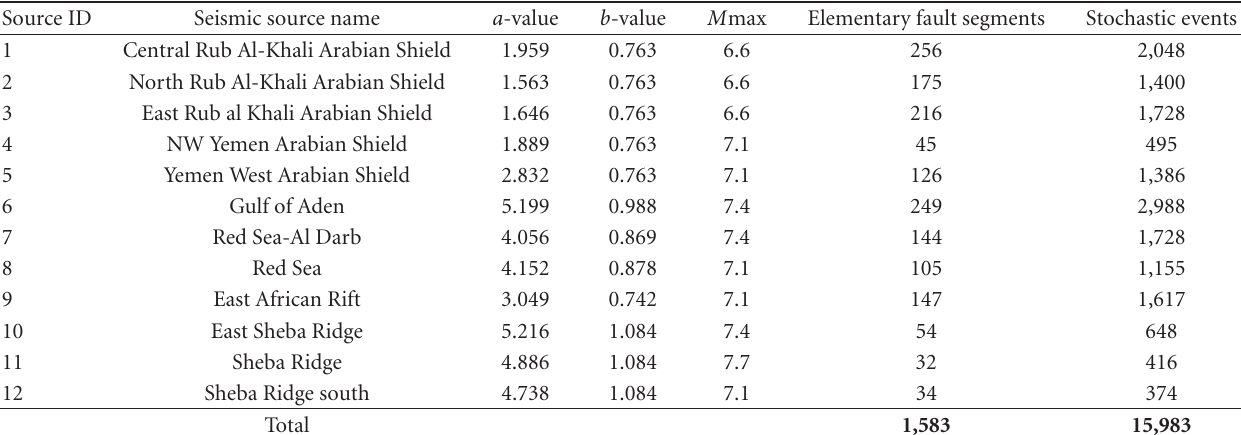
Table 2: Characteristics of seismic source